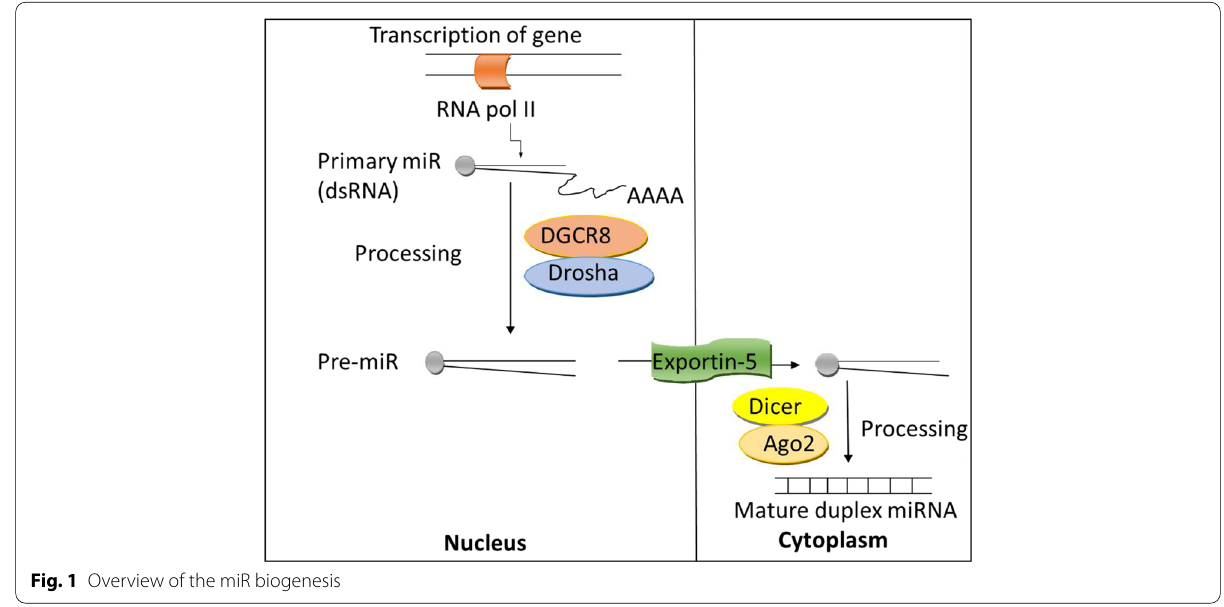
Fig. 1 Overview of the miR biogenesis